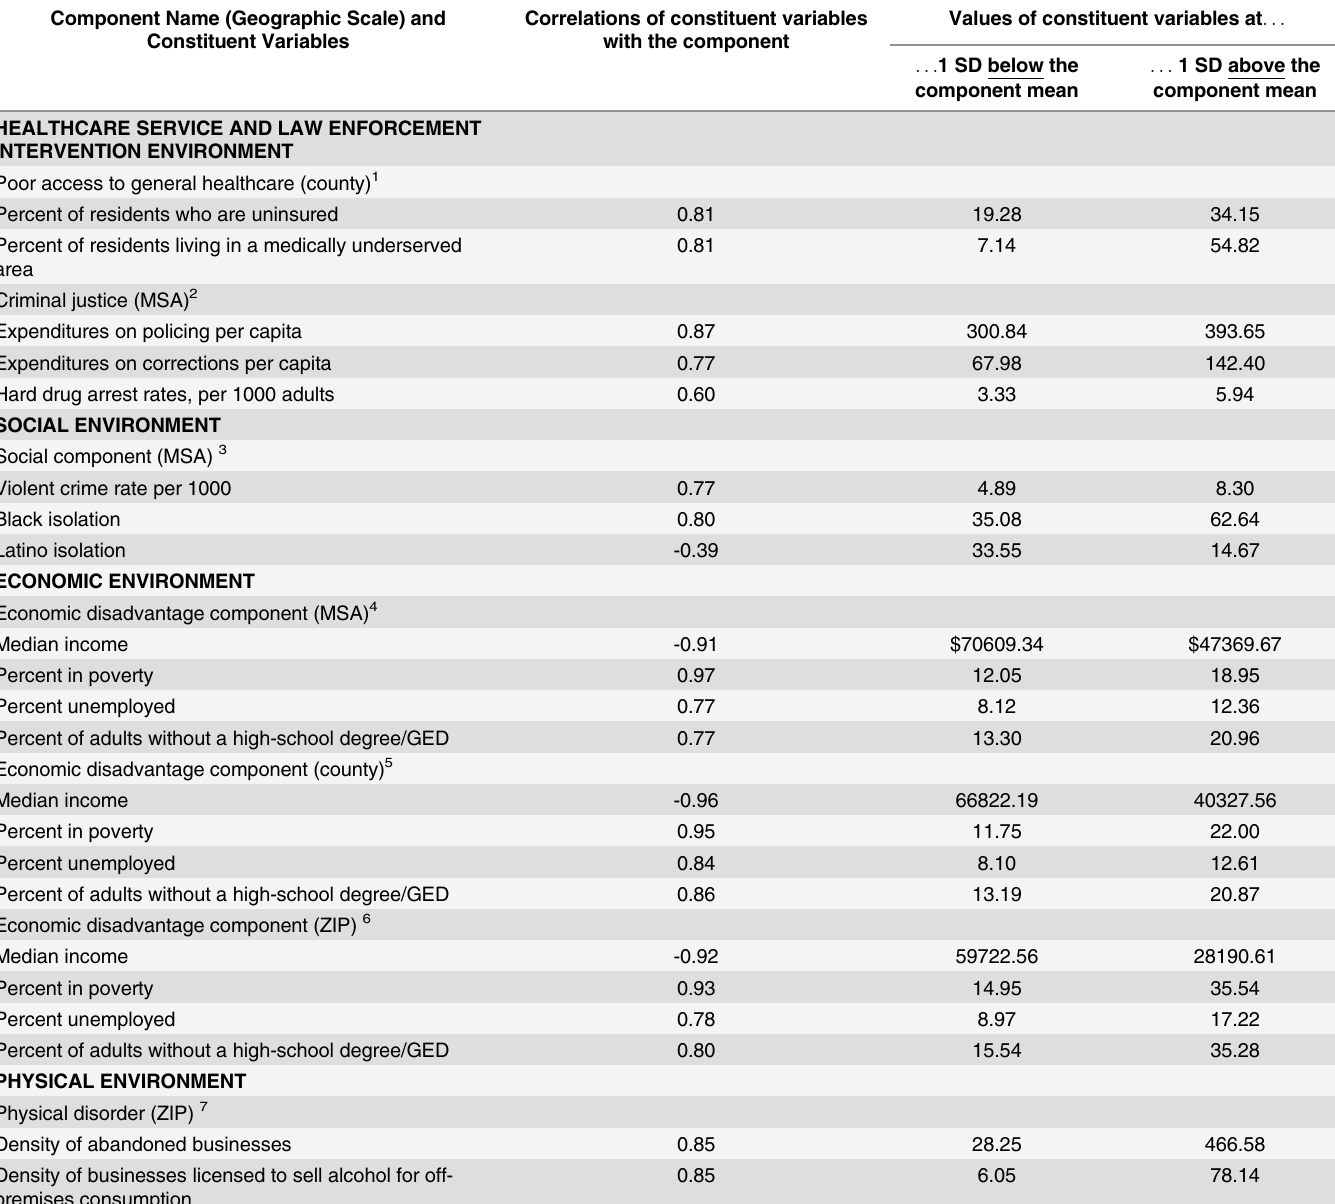
Table 2. Components Generated by the Principal Components Analysis. Component Name (Geographic Scale) and Constituent Variables